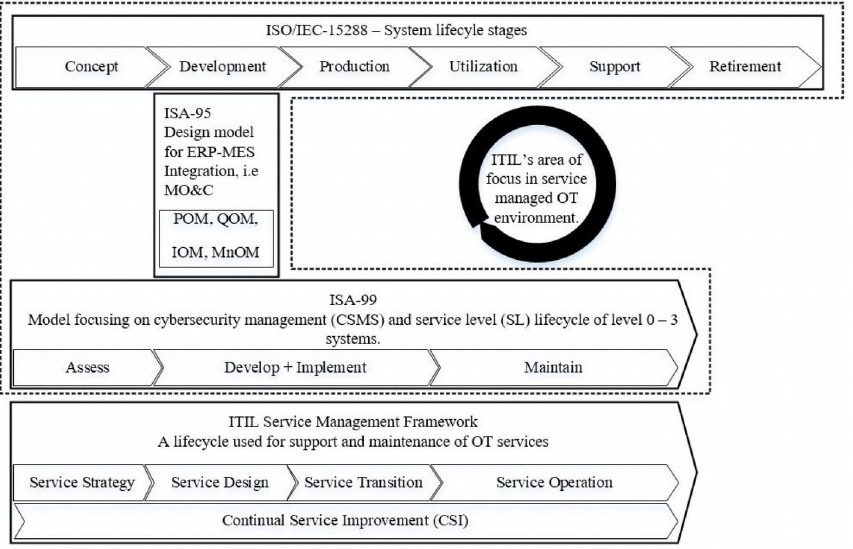
Figure 3. The unified theoretical framework, i.e. the landscape framework with ITIL adapted to OT